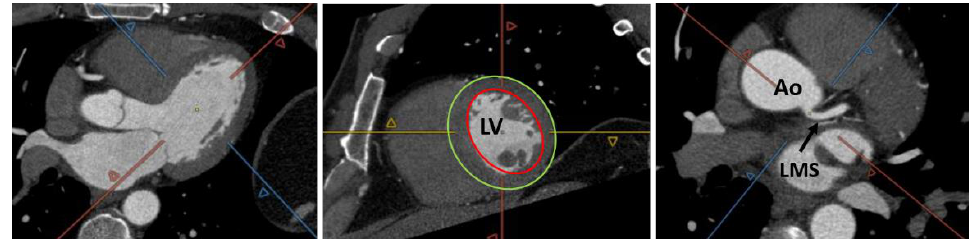
Figure 5. Computed tomography images showing the possibility of combining ejection fraction and coronary artery evaluation. LV = left ventricle, LMS = left main stem, Ao = aorta.